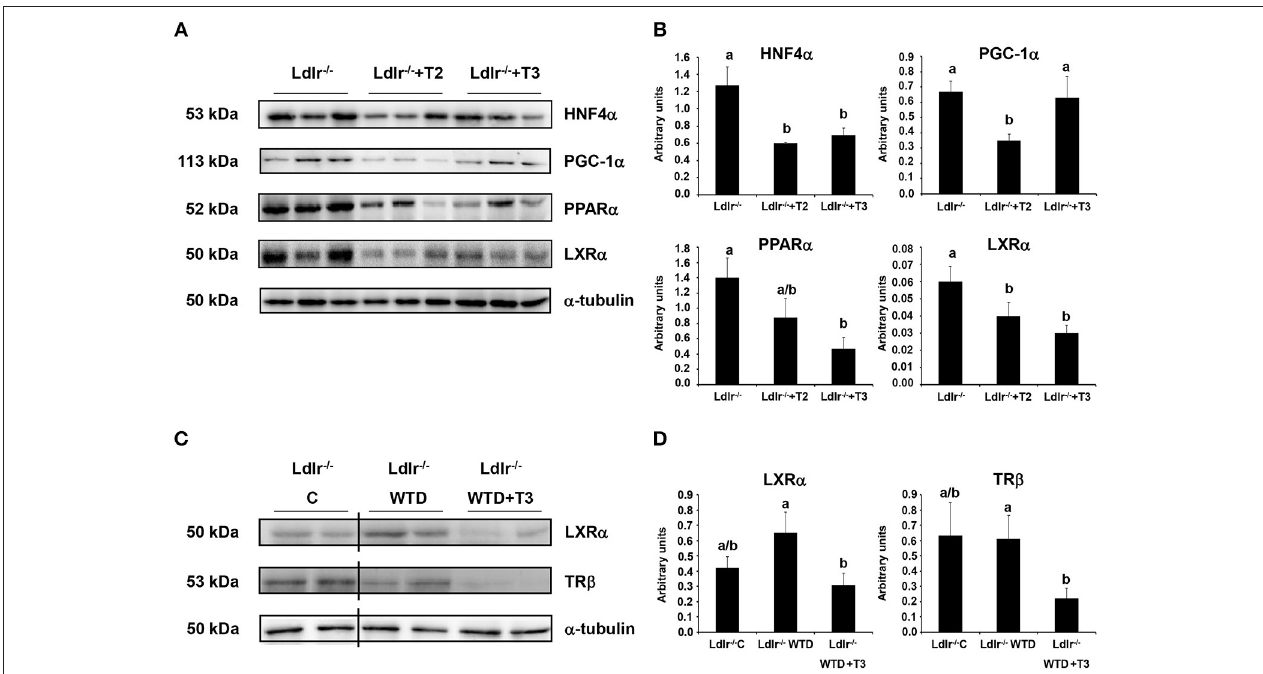
FIGURE 8 | Effects of T3 and T2 on nuclear factors in liver of Ldlr − / − mice. (A) Representative Western blot analyses of HNF4 α , PGC-1 α , PPAR α , and LXR α protein levels in Ldlr − / − , Ldlr − / − + T2, and Ldlr − / − + T3 mice. Liver nuclear protein contents were normalized on α -tubulin. Protein load was 30 µ g/lane. (B) Quantitative analysis of protein expression levels. Results are expressed as arbitrary units (means ± SD; n = 3). Bars labeled with dissimilar letters are significantly different ( p < 0.05). (C) Representative Western blot analyses of LXR α and TR β protein levels in Ldlr − / − mice fed with either a chow ( Ldlr − / − C) or a western type diet ( Ldlr − / − WTD) and treated with T3 ( Ldlr − / − WTD + T3). Liver nuclear protein contents were normalized on α -tubulin. Protein load was 30 µ g/lane. The vertical lines indicate cuts in the membranes to avoid to display samples not related to the used model. (D) Quantitative analysis of nuclear protein content of LXR α and TR β in Ldlr − / − C, Ldlr − / − WTD and Ldlr − / − WTD + T3 mice. Results are expressed as arbitrary units (means ± SD; n = 4). Bars labeled with dissimilar letters are significantly different ( p <